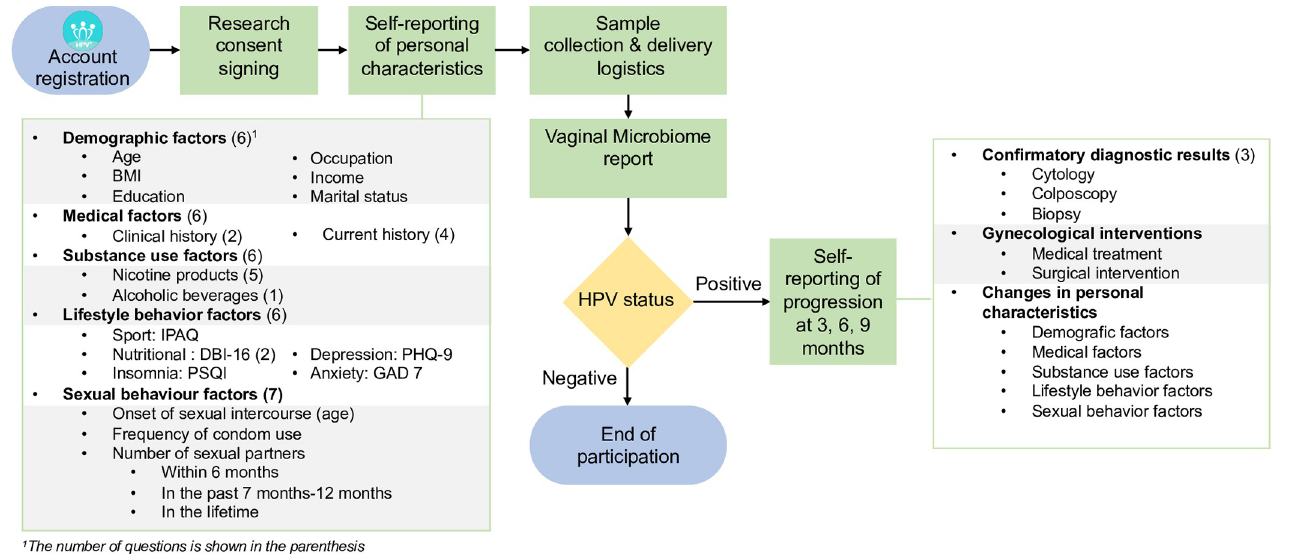
Fig 3. Translational eHealth platform flowchart for the collection for participant-reported outcomes (PROs). Legend: IPAQ = international physical activity questionnaires. DBI = diet balance index. PSQI = Pittsburgh sleep quality index. PHQ-9 = Patient Depression Questionnaire-9. GAD 7 = Generalized Anxiety Disorder